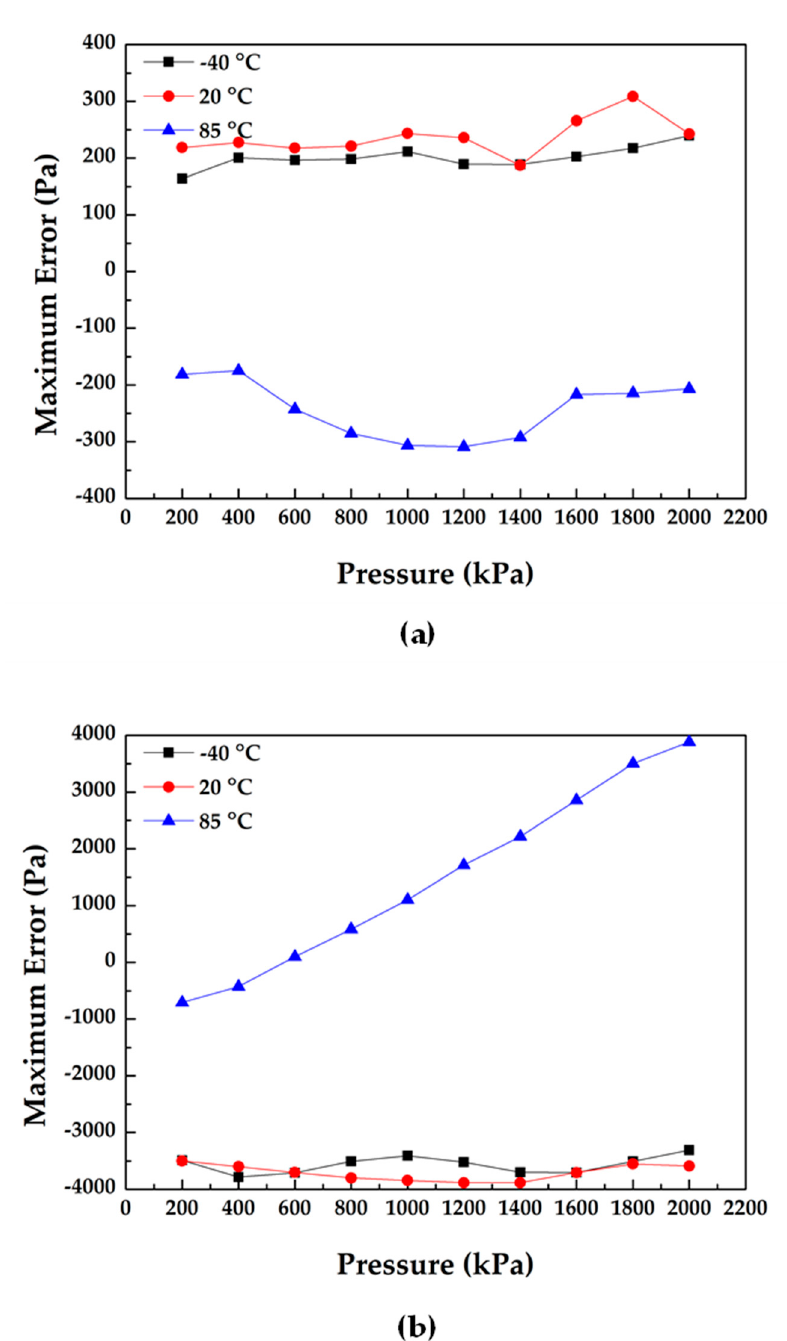
Figure 7. Experimental results: ( a ) the maximum measurement errors of the temperature compensation method based on differential outputs and a temperature sensor in three cycles and three different temperatures and ( b ) the maximum measurement errors of the self-temperature compensation method in three cycles and three different temperatures.